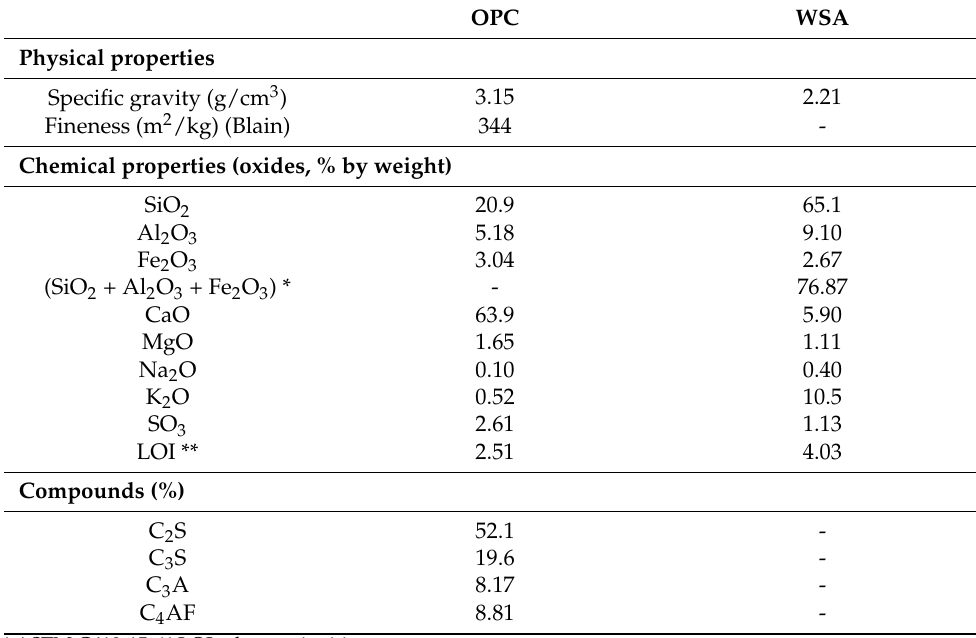
Table 1. Physical and chemical composition of the cement and wheat straw ash. OPC